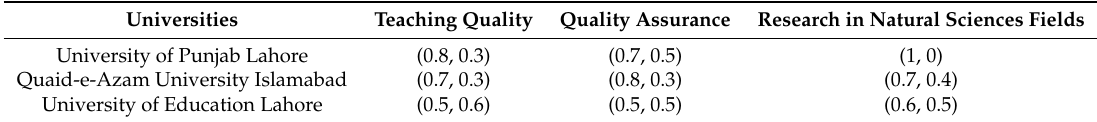
Table 3. Pythagorean fuzzy